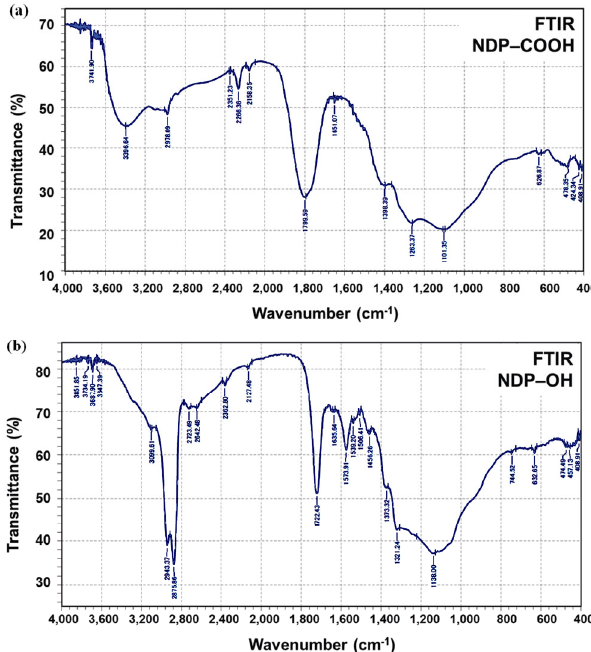
Fig. 1 FTIR transmittance spectra of (a) NDP–COOH and (b) NDP–OH.